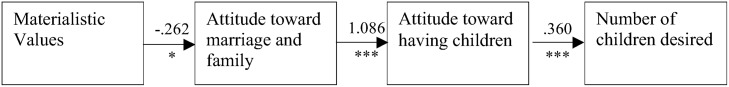
The Modified Incompatibility of Materialism and Children Model.
χ
2 (3) = 2.74, p = .43, CFI = 1.00, RMSEA = 0.00, -0.006 < CI < -0.215 (indirect effect from Materialistic values to Number of children desired). Note: * p < .05, *** p < .001.